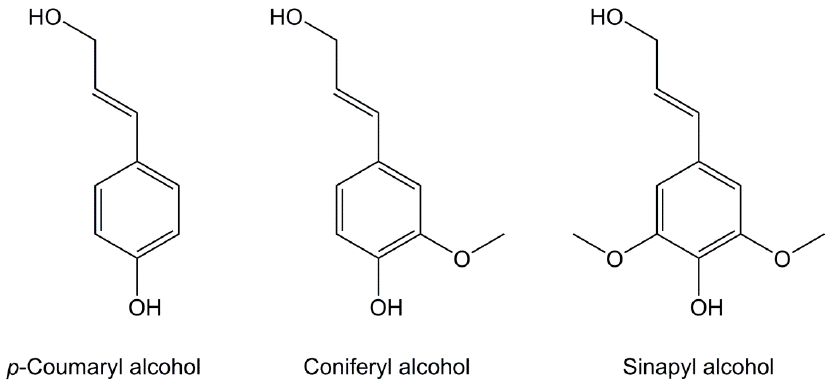
Figure 5. Main aromatic subunits found in lignin.